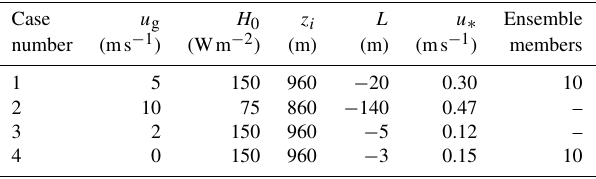
Table 1. Properties of the simulation cases: geostrophic wind speed ( u g ), sensible heat flux at the surface ( H 0 ), boundary layer height ( z i ), Obukhov length ( L ) and friction velocity ( u ∗